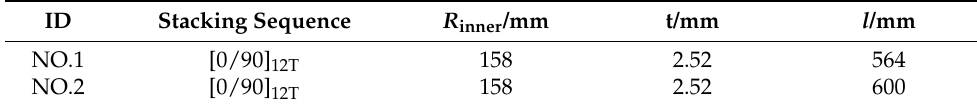
Figure 5. Geometry of the cylindrical shell. Table 1. Dimensions of the composite cylinders.